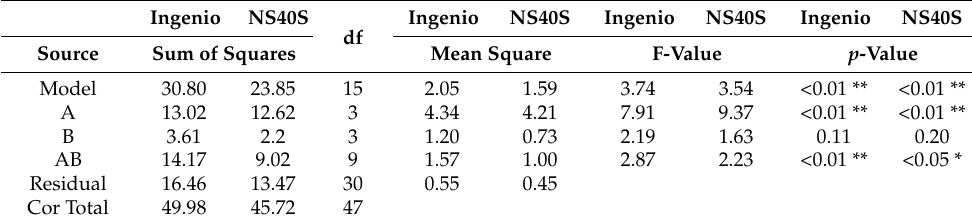
Table 9. ANOVA table for grain yield in